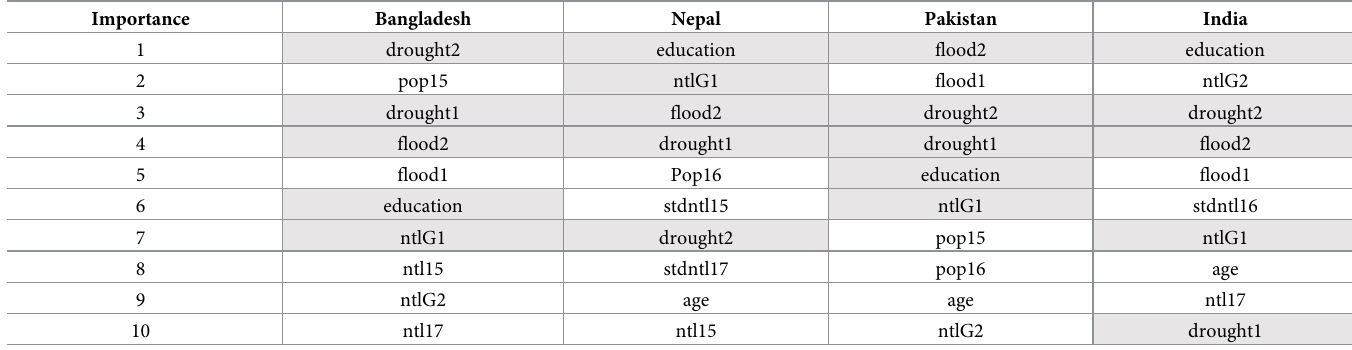
Table 6. Predictor